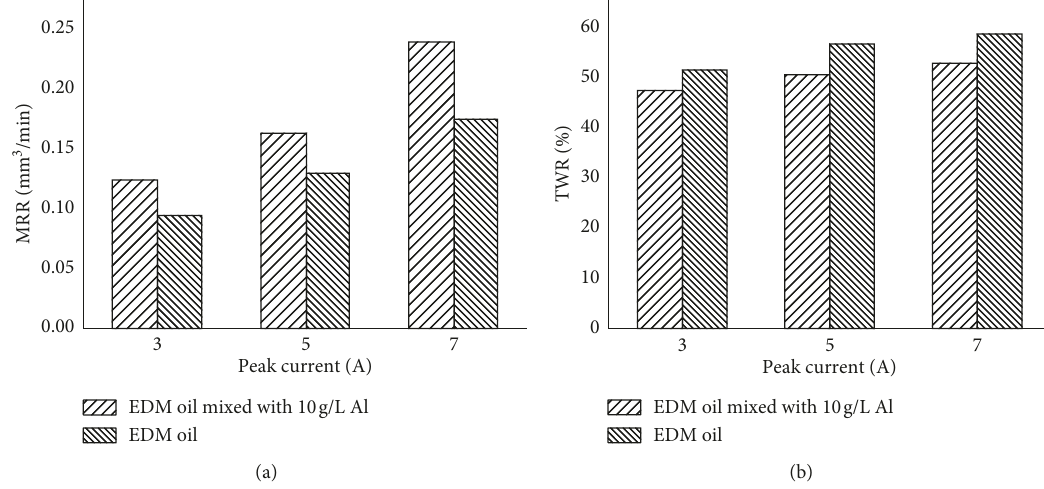
Figure 7: Influence of the peak current on the machining performance in different dielectric